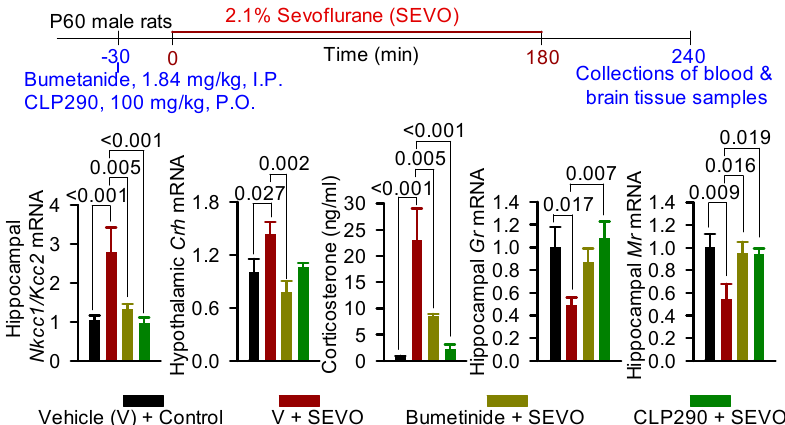
Figure 1. Acute stress-like effects of sevoflurane in postnatal day (P) 60 male rats. Alleviating effects of pretreatments with bumetanide or CLP290. Top panel: study design. Data are mean ± SEM of 5 rats/group. The p -values of multiple pairwise comparisons are shown in the respective plots above the horizontal lines. I.P.: Intraperitoneal; P.O.: Per os; Nkcc1 : Na + − K + − 2Cl − gene; Kcc2 : K + − 2Cl − gene; Crh: Corticotropin-releasing hormone gene; Gr : Glucocorticoid receptor gene; Mr: Mineralocorticoid receptor gene. See Supplementary material for details.